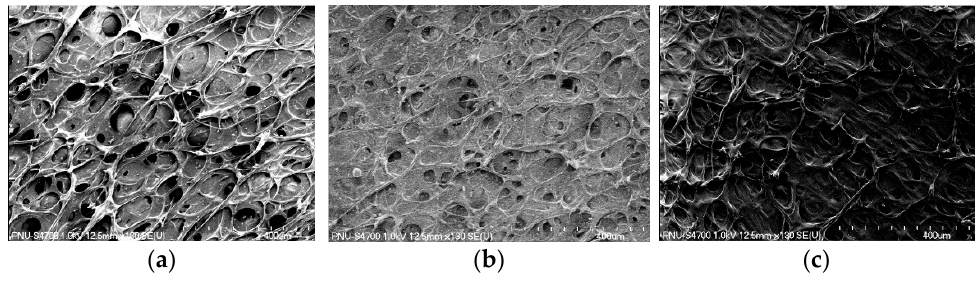
Table 2. Density change of EPS with temperature conditions.